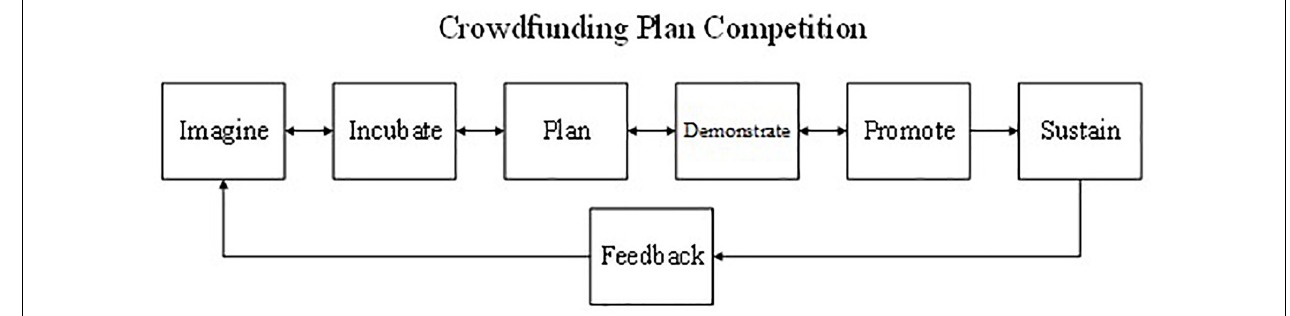
FIGURE 1 | Crowdfunding plan competition. Adapted from Evans et al. (2007) and Jolly (1997).